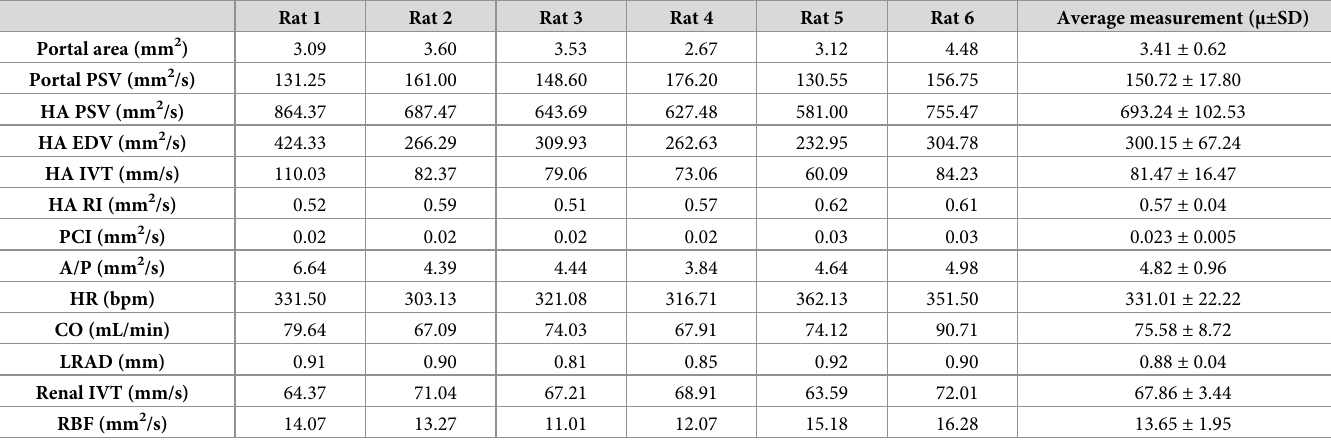
Table 4. Cardiovascular hemodynamic, hepatic and renal perfusion results obtained by